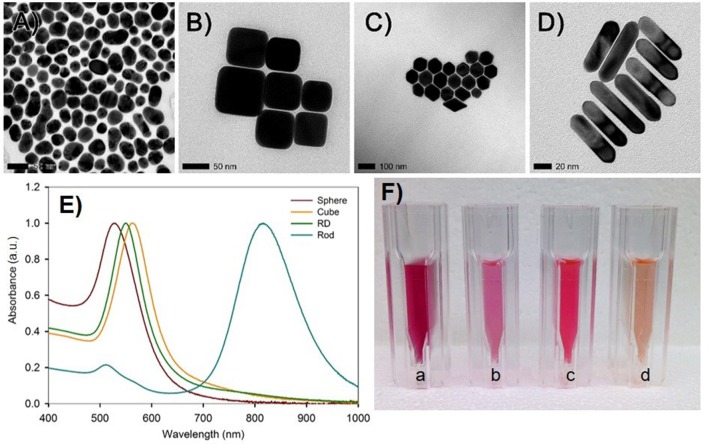
Characterization of gold nanoparticles. TEM images of gold nanostructure (A) spheres, (B) truncated cubes, (C) rhombic dodecahedra, and (D) rods. (E) UV-visible absorption spectra showing characteristic absorption for each nanostructure. (F) Pictured from left (a) to right (d): nano-spheres, truncated cubes, rhombic dodecahedra, and rods as synthesized in aqueous suspension.